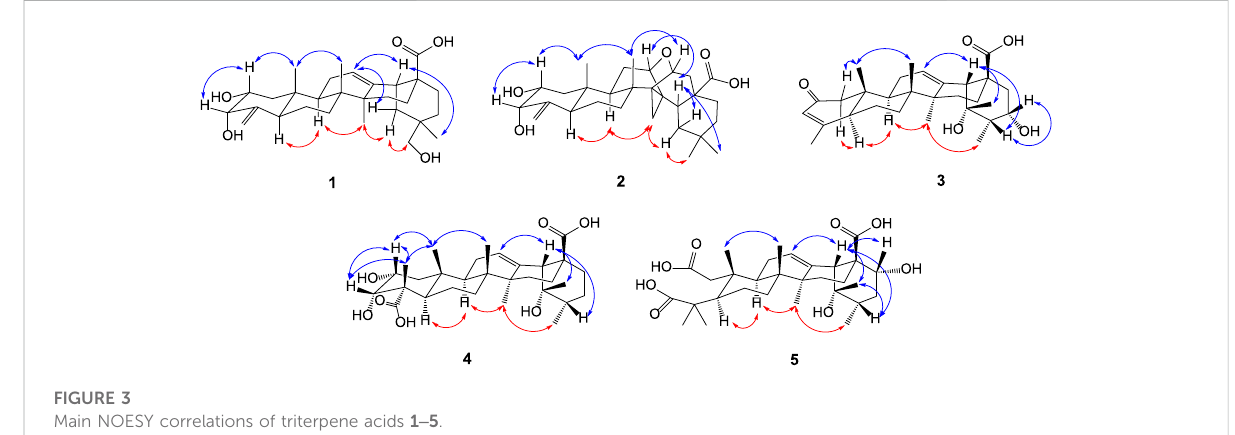
FIGURE 3 Main NOESY correlations of triterpene acids 1 ‒ 5